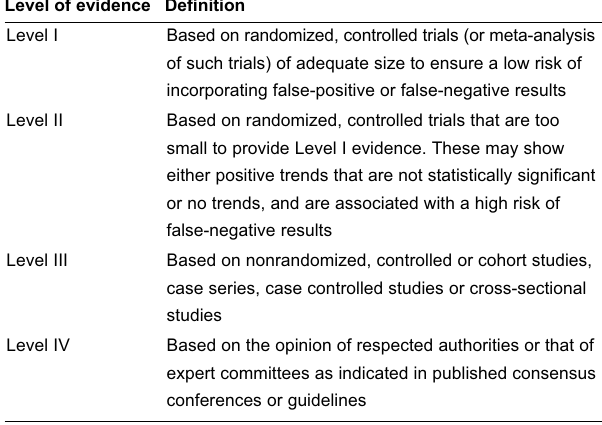
Table 3 Classification of level of evidence for